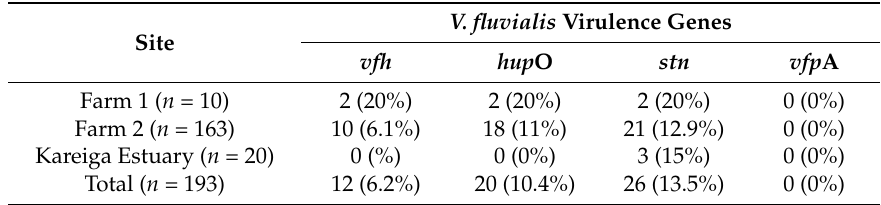
Table 4. Summary of V. fluvialis virulence genes detected from different sampling sites.